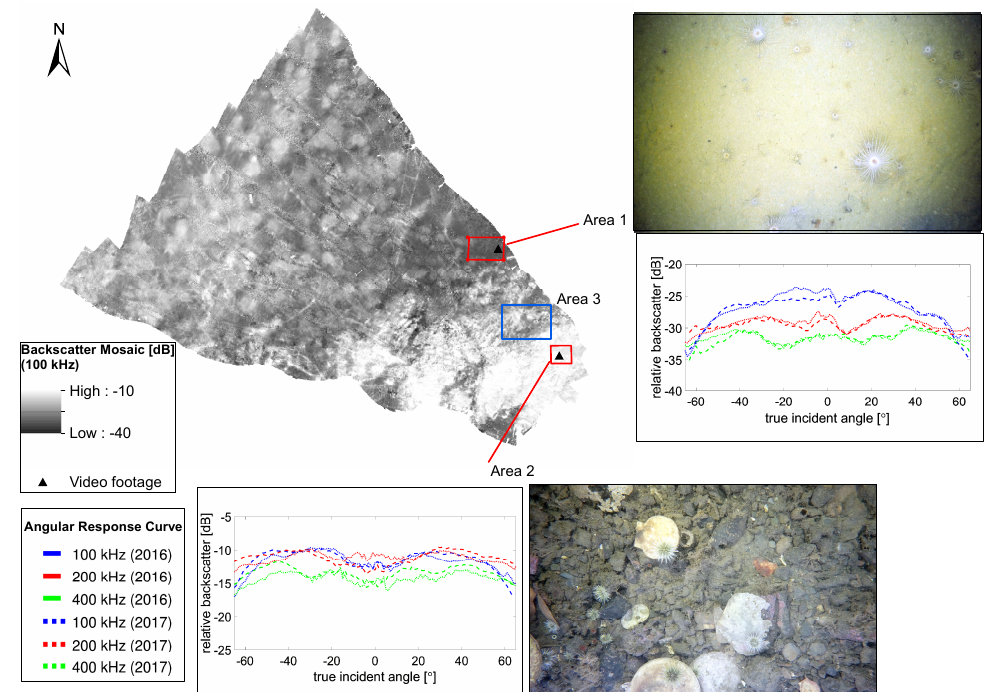
Figure 3. The processed ARCs from two different sediment types retrieved from the multispectral MBES dataset acquired in March 2016 and May 2017 in the Bedford Basin. The ARCs are obtained by averaging the backscatter values per incident angle within Areas 1 and 2. Area 1 indicates a muddy sediment, and Area 2 indicates gravel to boulders. The displayed backscatter mosaic (100kHz, 2016) has a spatial resolution of 2m by 2m.